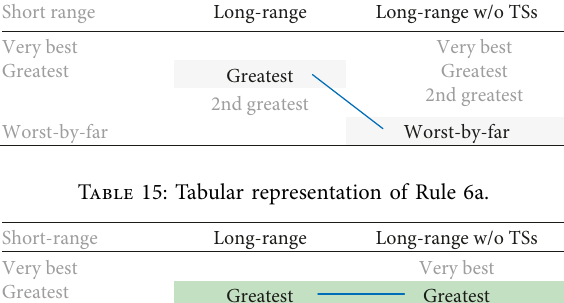
Table 9: Multiscale category values derived for the road-location shown in Figure 5.